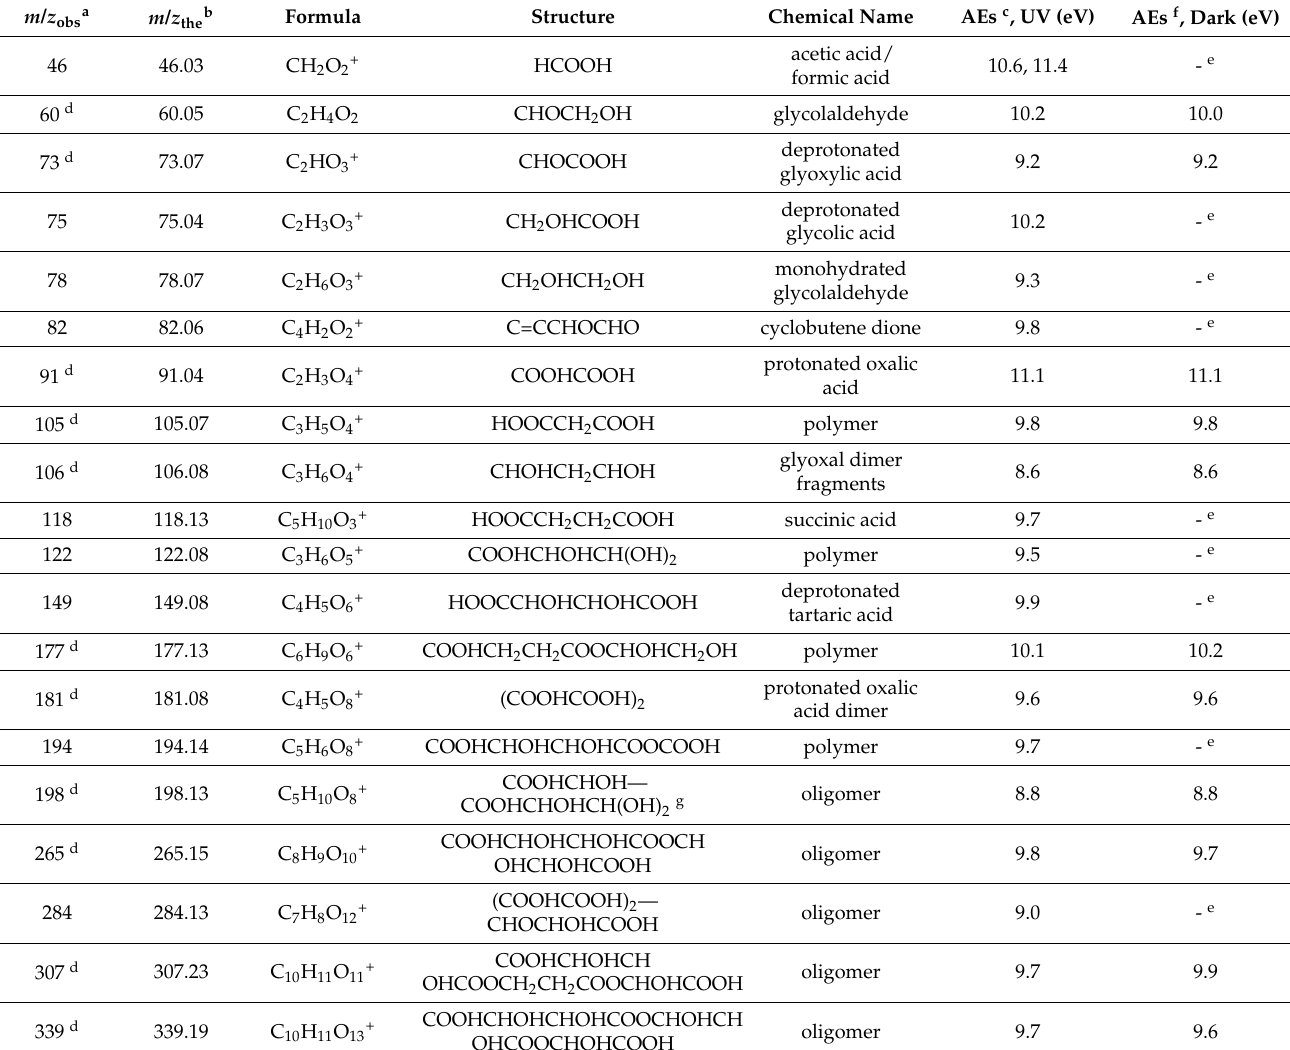
Table 1. Identifications of key reactants and product peaks in the positive mode at 12.0 eV. m / z obsa m / z